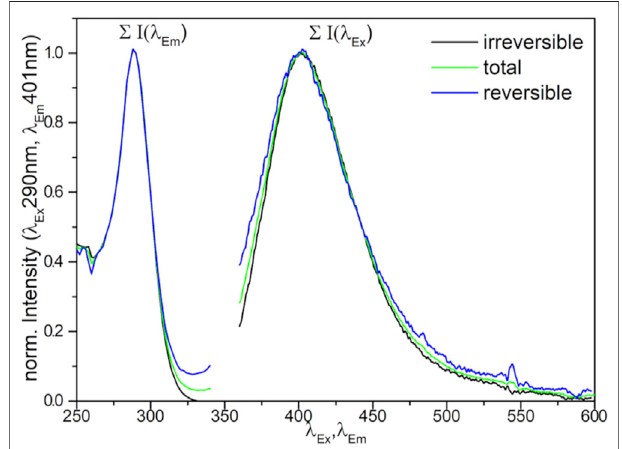
FIGURE 5 | Normalized loss of photoluminescence (difference spectra of 0.17 atom% Mn doped CaO on exposure to oxygen (total) and after reapplying vacuum (reversible).